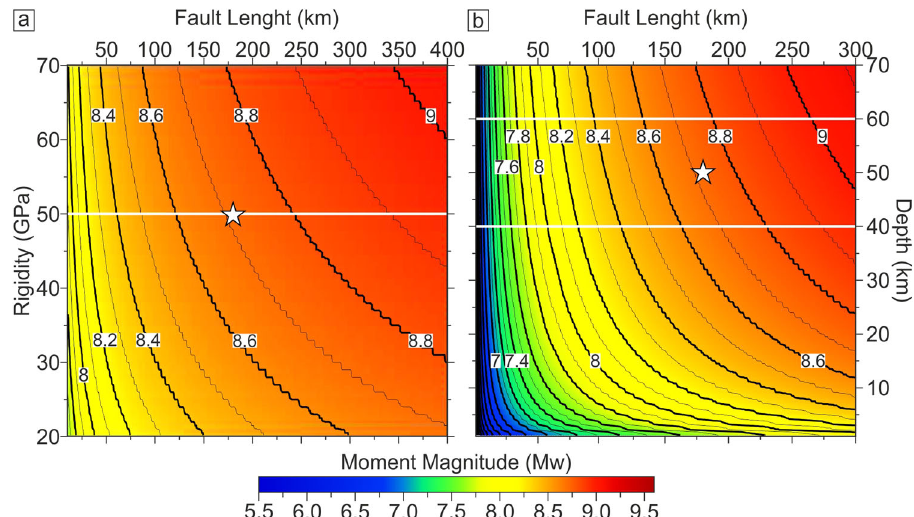
Fig. 3 Moment magnitude ( M w ). a Calculated earthquake magnitude ( M w ) as a function of fault length and rigidity ( µ ) according to the regional con fi guration and bulk-rock properties in the SW Iberian margin and tsunami results. White line highlights that assuming a µ ~ 50 GPa, the generation of a M w 8.7 earthquake (star) requires a fault length of ~180 km. Slip (15 m), focal depth (50 km) and fault dip (35°) were assumed as constant. b Calculated earthquake magnitude ( M w ) as a function of fault length and seismogenic depth according to the Horseshoe Abyssal plain Thrust (HAT) geometry, properties and tsunami modelling results. The star locates the M w value of an earthquake capable of generating a tsunami compatible with that of the 1755 event. White lines highlight the sesimogenic zone between 40 and 60 km depth. Rigidity ( µ = 50 GPa), slip (15 m) and fault dip (35°) were assumed as constant. See text for further explanations.